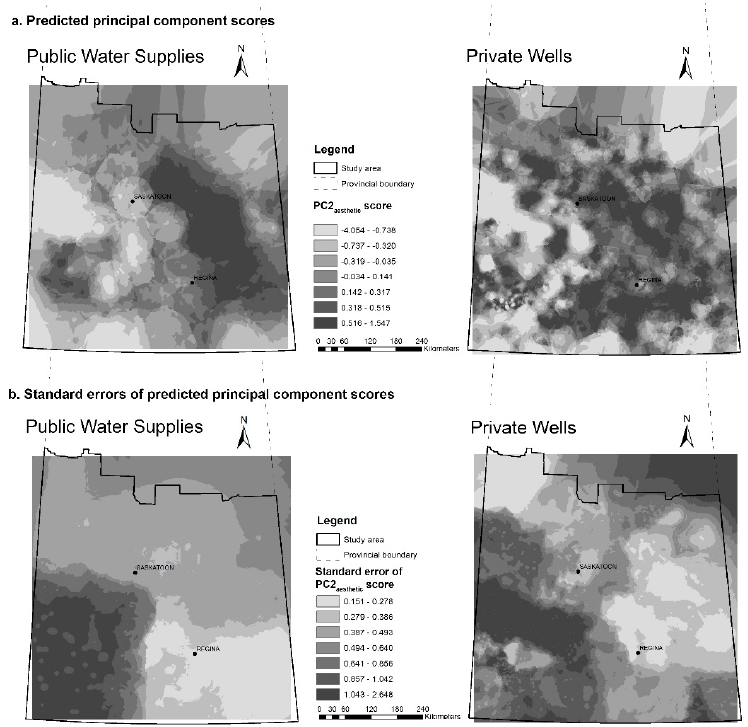
Figure A13. ( a ) Predicted PC2 aesthetic scores for public water supplies and private wells in study area; and ( b ) the corresponding prediction standard errors.